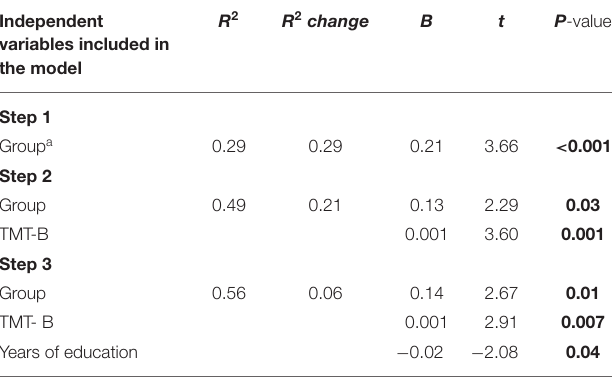
TABLE 5 | Predictors of 1 HbO 2 during usual walking. Independent variables included